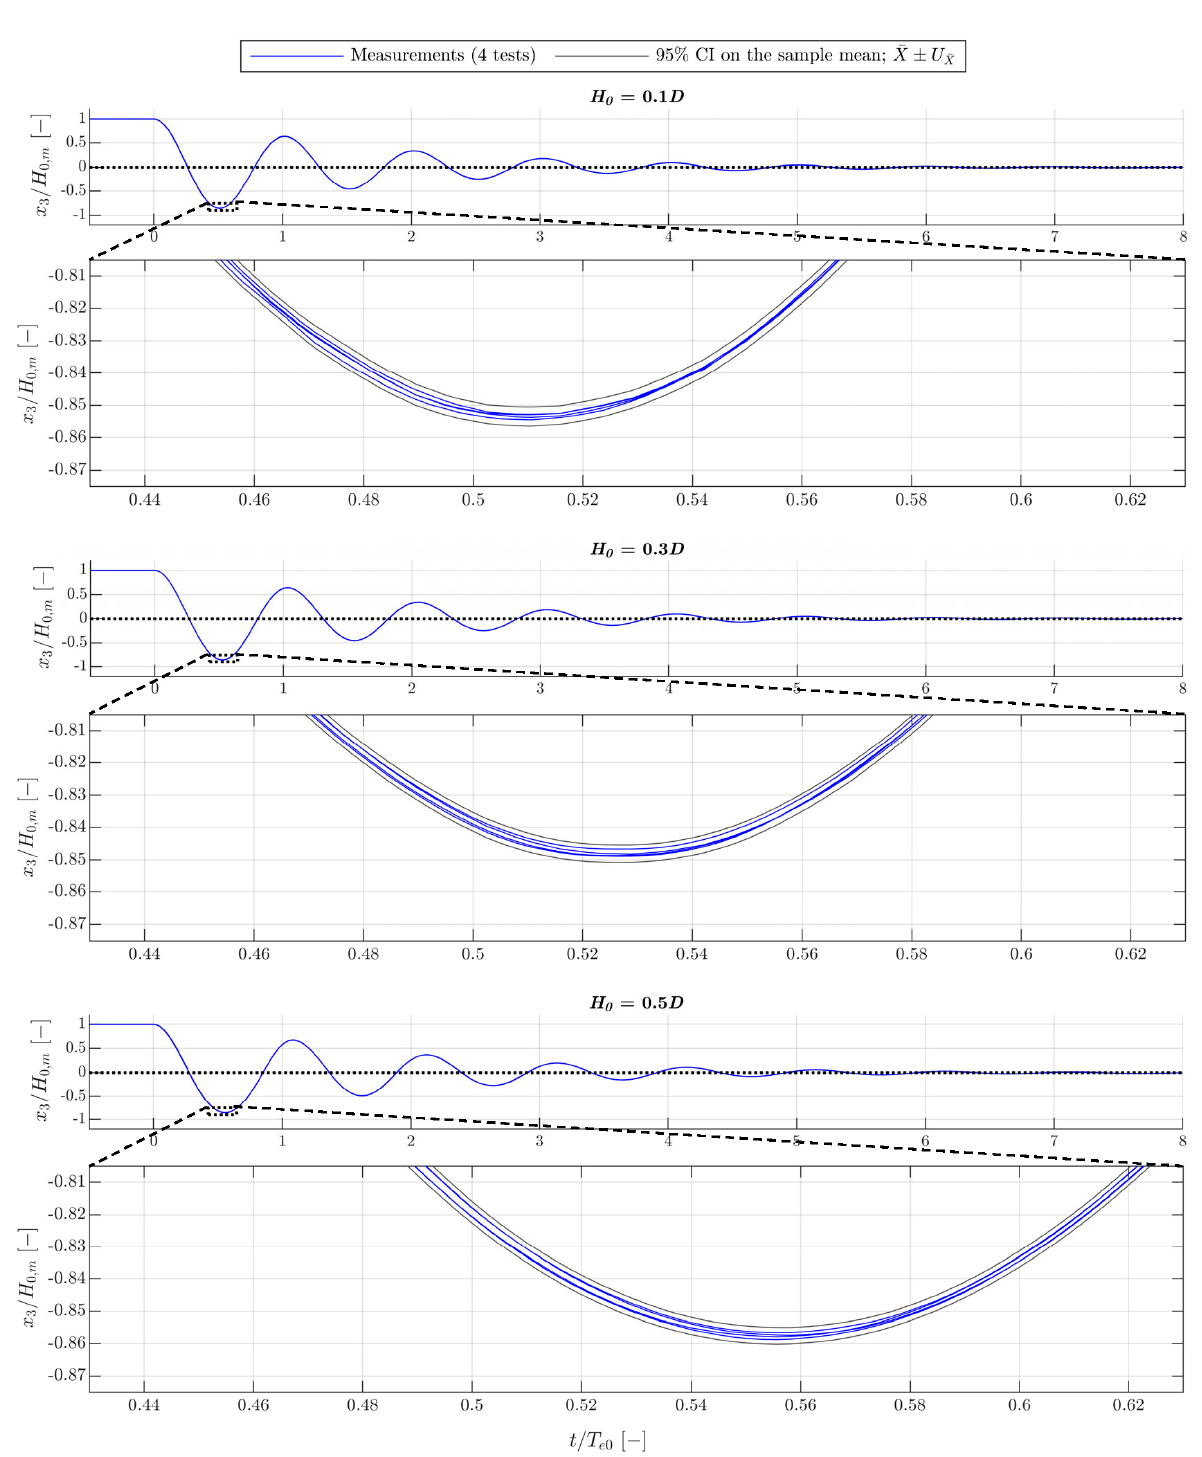
Figure 14. Normalized heave decay time series and 95% CIs with a zoom of the first trough.